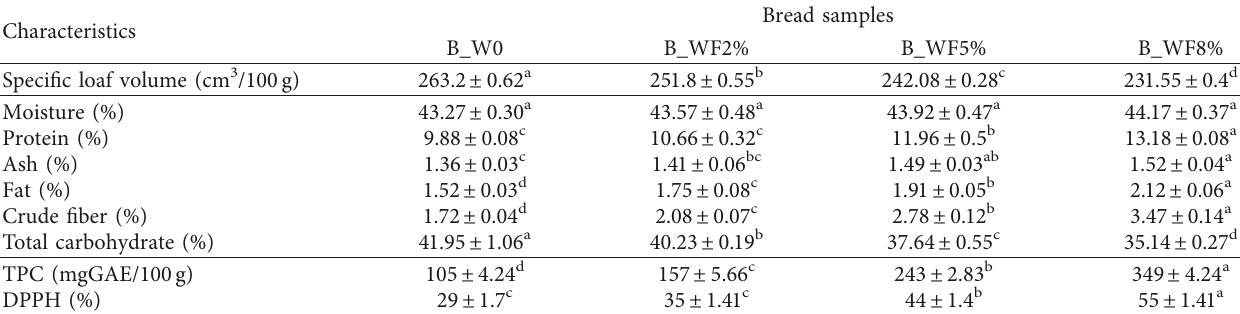
Table 2: Chemical characteristics of bread supplemented with fenugreek flour. Characteristics